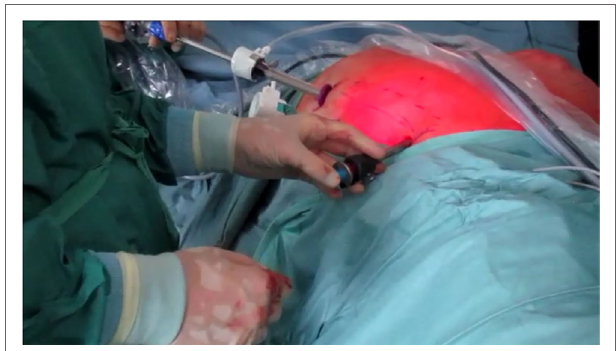
FIgURe 3 | Trocar position for the endoscopic anterior component separation on the right